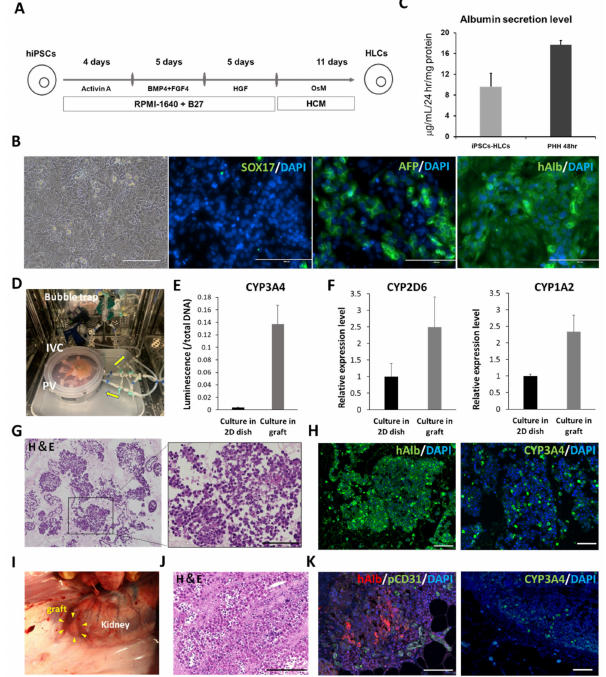
Figure 2. Functional analysis of cultured induced pluripotent stem cell-hepatocyte-like cells (iPSCs- HLCs) on the dish and iPSCs-HLCs seeded into the scaffold. ( A ) Protocol for differentiation induction to hiPSC-HLCs. ( B ) Bright field and immunostaining images of hiPSCs-HLCs at day 25 of differen- tiation induction. Left to right: bright field, SOX17, human albumin, and AFP. Scale bar = 200 µ m. ( C ) Comparison of ALB secretion level between cultured hiPSC-HLCs and primary human hepatocyte (PHH) on dishes. ( D ) Bioreactor for recellularization. ( E ) Comparison of CYP3A4 activity for the cultured hiPSC-HLCs in the scaffold and on the dish (mean ± SD, n = 3). ( F ) Comparison of relative CYP-related mRNA expression in the cultured hiPSC-HLCs in the scaffold and on the dish (mean ± SD, n = 3) ( G ) H&E staining of the recellularized scaffold. ( H ) Immunostaining images of the recellu- larized scaffold. Left: human albumin. Right: CYP3A4. Scale bar = 100 µ m. ( I ) Renal subepithelial implantation of the recellularized scaffold ( J ) Histological images of the scaffold observed after 14 d of the implantation. Scale bar = 50 µ m. ( K ) Immunostaining images of the implanted scaffold. Left: human ALB and pig CD31. Right: CYP3A4. Scale bar = 100 µ